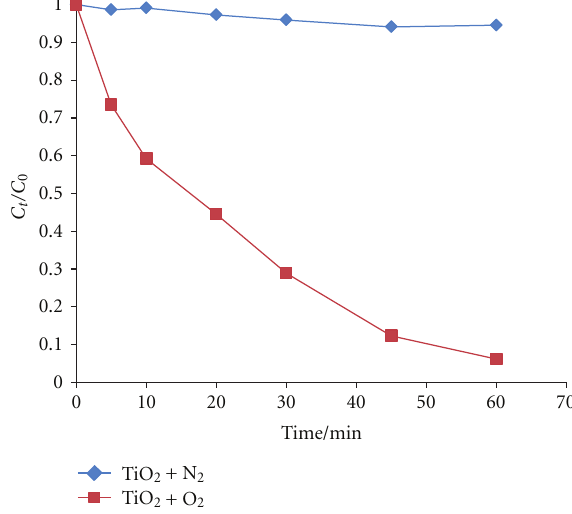
Figure 8: E ff ect of type of gas on photodecolorization of cobalamin by TiO 2